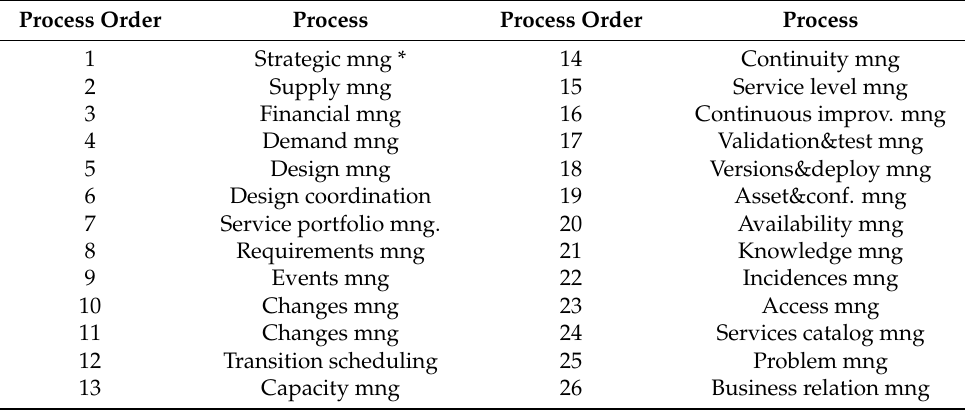
Table 3. Processes of the sequence